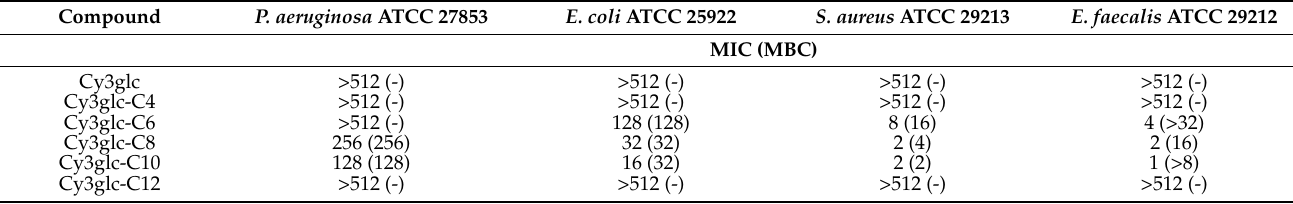
Table 1. Minimum inhibitory concentrations (MICs) and minimum bactericidal concentration (MBCs), in µ g/mL, of Cy3glc and Cy3glc-fatty acid derivatives against two Gram-negative and two Gram-positive reference strains. Compound